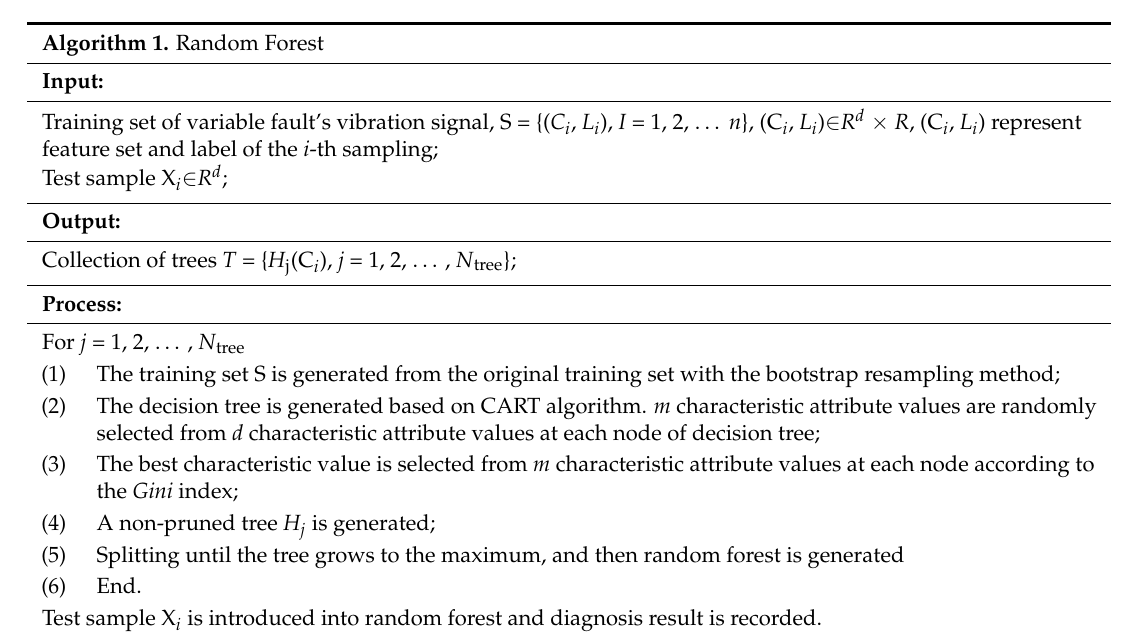
Figure 8. Random forest structure. Table 2. Random forest algorithm.